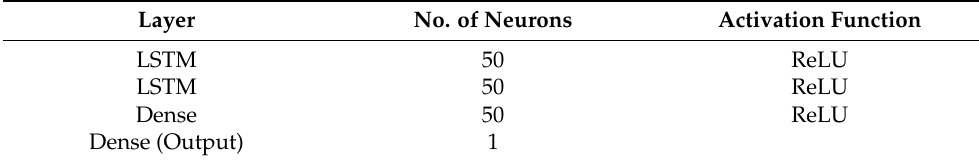
Table 7. Layer configuration of the LSTM model. Layer No. of